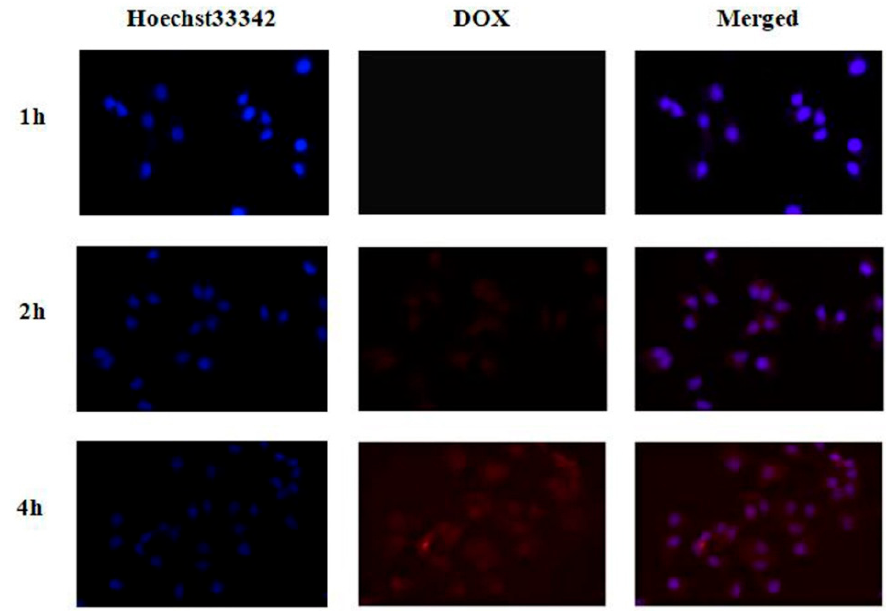
Figure 7. Confocal laser scanning microscopy images of MCF-7 cells treated with DOX prodrug micelles for 1, 2 and 4 h.